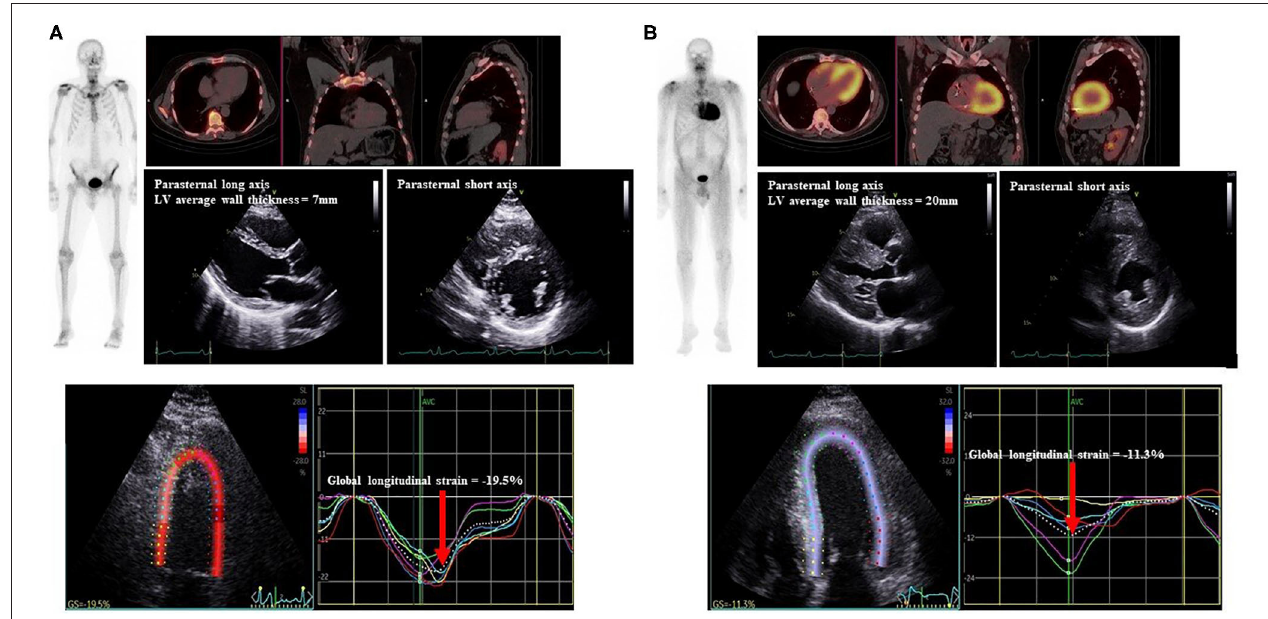
FIGURE 2 | Representative Echocardiogram and 99m Tc-DPD scintigraphy of study patients. Echocardiograms with parasternal long and short axis views with LV wall thickness measured, demonstration of LV GLS (red arrow), 99m Tc-DPD whole body sweep and SPECT-CT demonstrating (A) negative scintigraphy, normal LV wall thickness and GLS and (B) positive scintigraphy, increased LV wall thickness and reduced LV GLS. 99m Tc-DPD, Technetium-99m 3,3-diphosphono-1,2-propanodicarboxylic acid; LV, Left ventricle; GLS, global longitudinal strain; SPECT-CT, single-photon emission computed tomography-computerized